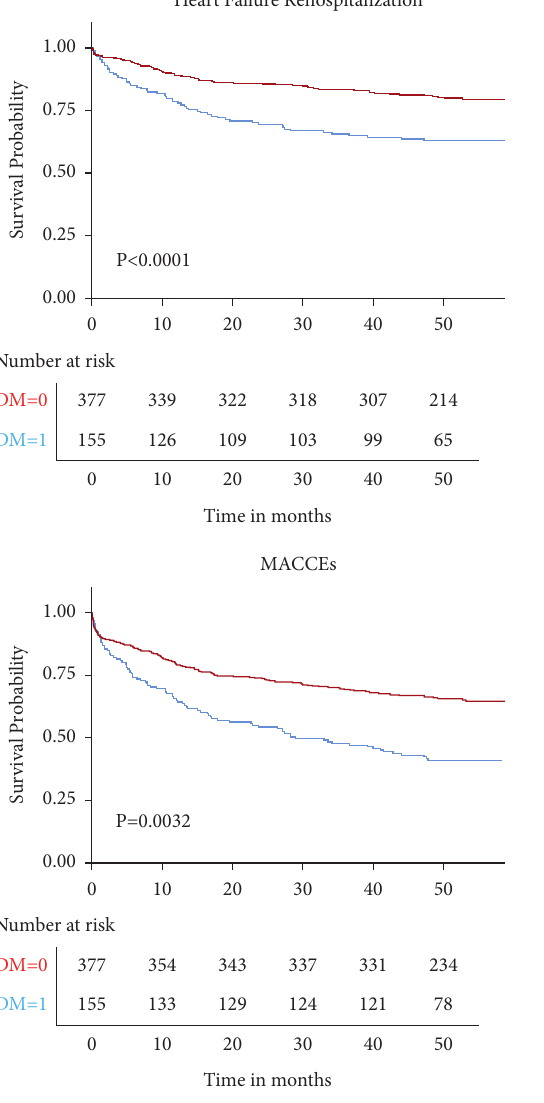
Figure 1: Kaplan–Meier event-free survival curves for composite endpoints (all-cause mortality, ischemic stroke, and heart failure rehospitalization) in elderly VHD patients with diabetes vs. nondiabetes. MACCEs, major adverse cardiac and cerebrovascular events; VHD, valvular heart